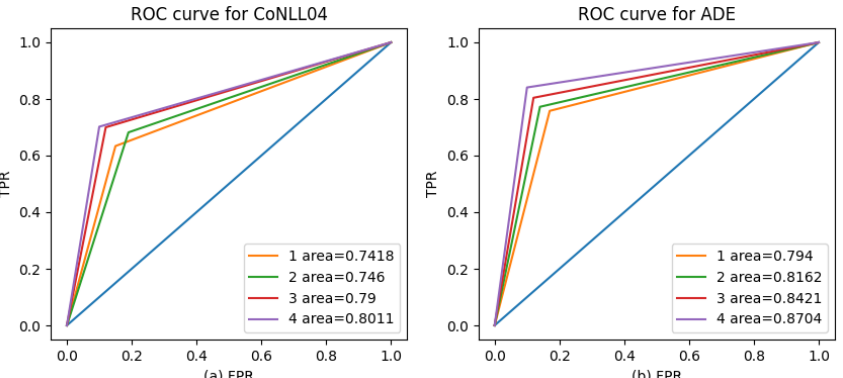
Figure 8. Receiver operating characteristic curves of the method compared to other model. ( a ) is the ROC curve for CoNLL04 dataset. ( b ) is ROC curve for ADE dataset. The number “1” and “2” in left image represent the model in paper [12] and paper [13] respectively, unlike it represent the model in paper [7] and paper [12] respectively. The number “3” refers to baseline and “4” refers to our